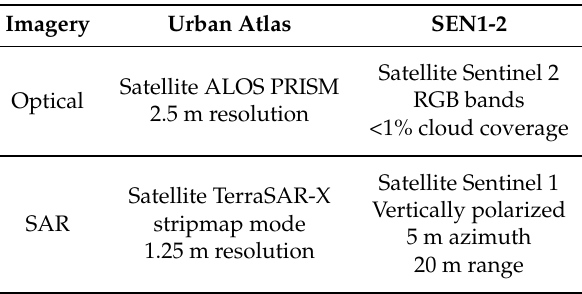
Table 1. Specifications for the optical and SAR acquisition.